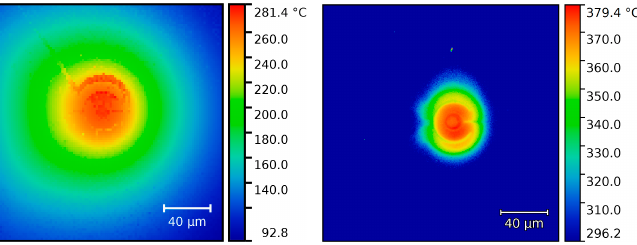
Figure 5. 3rd Design: ( left ) SThM temperature scan; ( left ) Near Infrared temperature image at 8.84 mW, before probe contact; ( right ) NIR temperature subtraction between no contact and contact